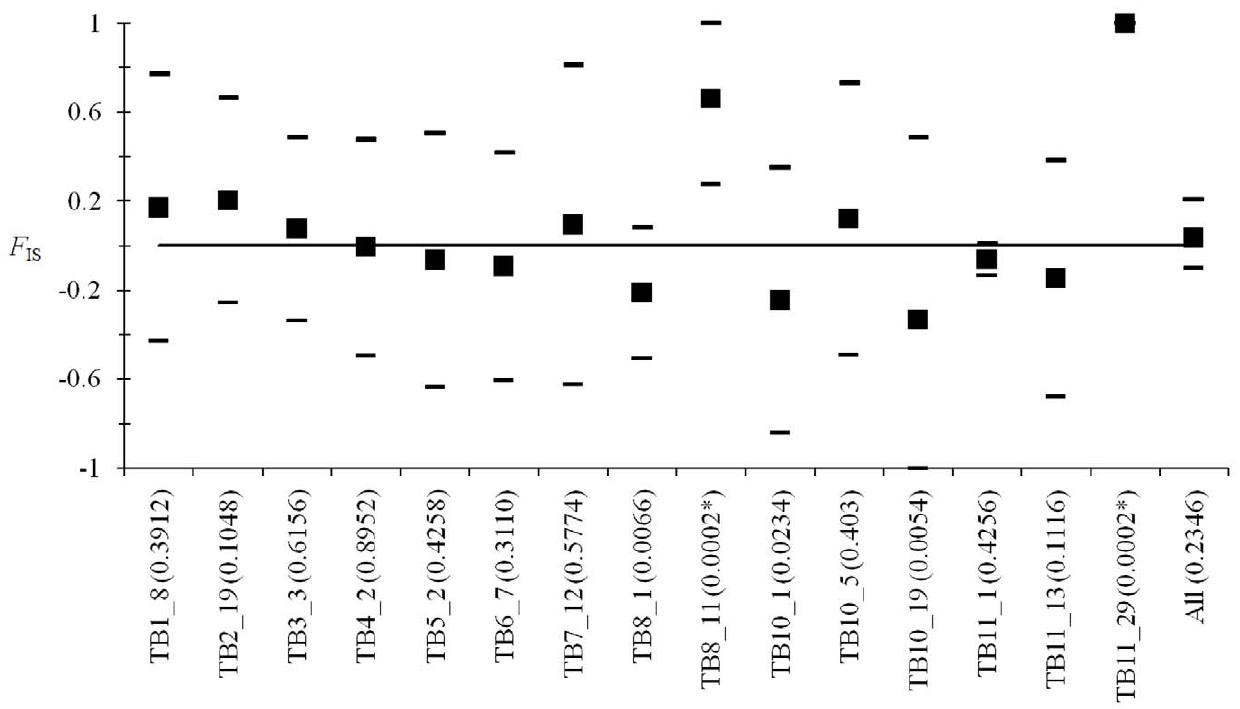
Figure 2. Unrooted NJTree between the different strains of T.evansi . The tree is based on Cavalli-Sforza and Edward’s chord distance matrix computed over all the 15 loci. Name of the strains: first letter side as regard to Nile, site name, month, year of sampling and number of the strain. Reference strains are in bold. The different sites are represented with different symbols.